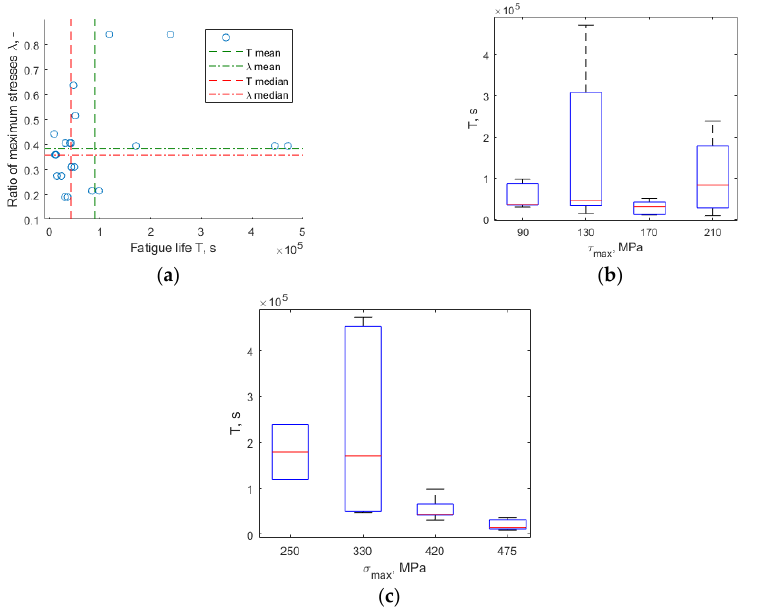
Figure 7. Fatigue life T in context: ( a ) ratio of maximum stresses λ ; ( b ) maximum shear stress τ max ; ( c ) maximum normal stress σ max .